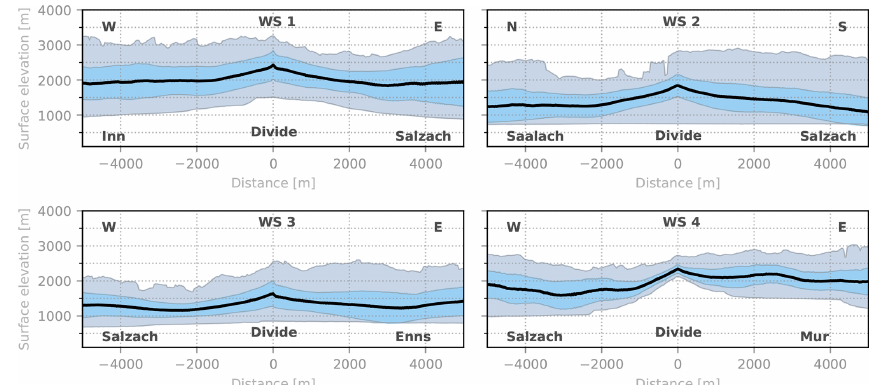
Figure 4. Generalized swath profiles (Hergarten et al., 2014) across the profile lines (drainage divides) shown in Fig. 1. The profiles have a half-width of 5km to each side of the profile line (drainage divide). The black line indicates the mean elevation. The blue contours represent the standard deviation, and the grey contours represent the extreme values within the swath